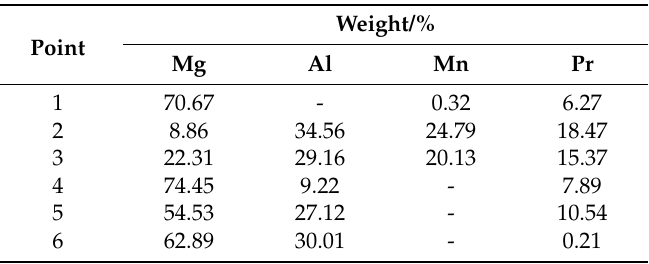
Figure 3. X-ray elemental map of Mg, Al, Zn and Pr of the surface of AZ91-1.0%Pr alloy. Table 1. EDS analysis results of points in Figure 2.